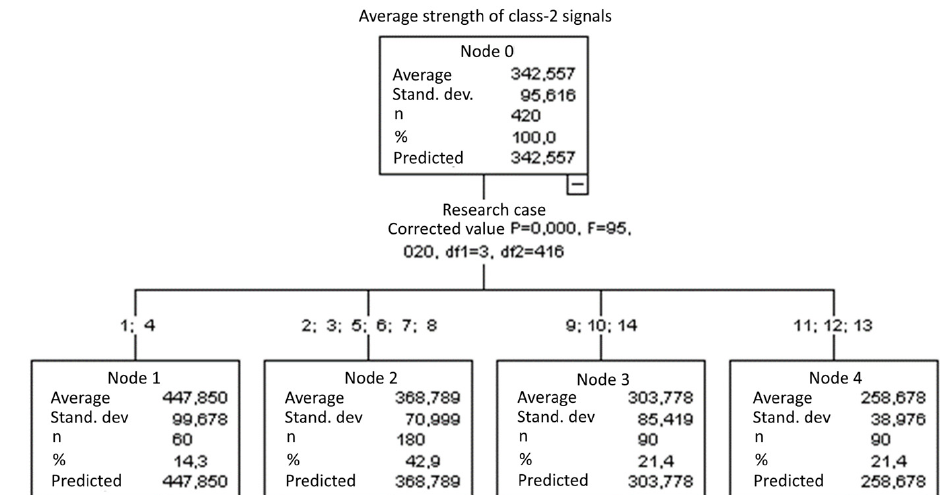
Figure 20. Classification tree for the average strength of class-2 signals.